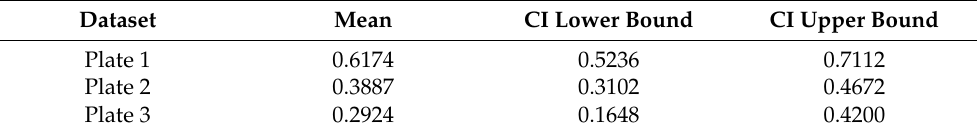
Table 14. Resulting void fraction for the three manufactured plates with their resp. 95% CI.